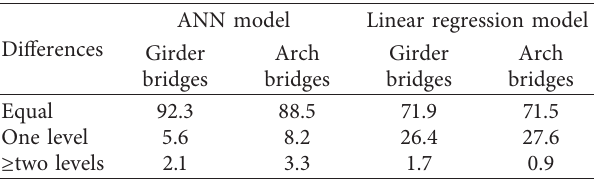
Table 6: The comparison between the ANN models and the linear regression models of the girder bridges and arch bridges (%). The results demonstrate the difference between the prediction value and the actual value of level zero, level one, and the other